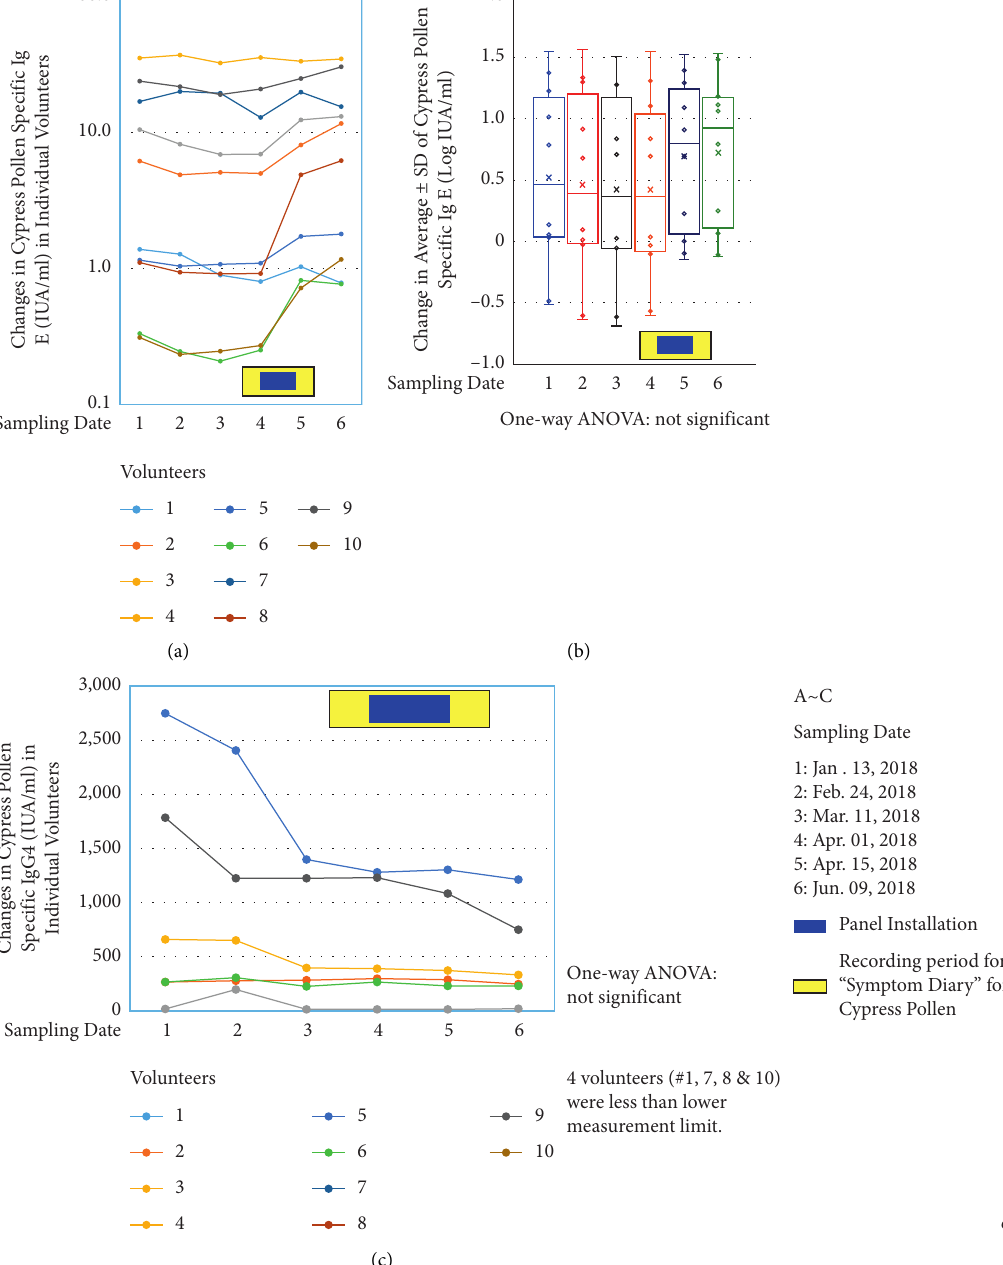
Figure 5: Changes in immunoglobulins. (a) Actual changes in cypress-specific IgE in 10 volunteers. The X -axis shows the six blood collection times described in Figure 2(b) and the lower right part of this figure. The Y -axis is represented logarithmically. As shown in the lower right part, the yellow box shows the period when the “Symptom Diary” was kept for cypress pollen allergy, while the blue box indicates the 2 weeks of exposure to CCSNOP. (b) The data in panel A are shown as box plots of cypress-specific IgE of 10 volunteers with average ± standard deviations. The Y -axis is shown as Log IgE IUA/ml. There were no significant differences identified among these data by one-way ANOVA analysis. The blue and yellow boxes are the same as in panel (a). Sampling dates # 1 to 6 are the same as in Figure 2(b) and are shown in the lower right part of this figure. (c) Changes in cypress-specific IgG4 (IUA/ML) in individual volunteers, except volunteers # 1, 7, 8, and 10 whose numbers are written in gray. These four volunteers showed less than the measurement lower limit (200 IUA/ml) for all six sampling times. There were no statistical differences between sampling times as determined by one-way ANOVA analysis. The blue and yellow boxes are the same as in panel (a). Sampling dates # 1 to 6 are the same as in Figure 2(b) and are shown in the lower right part of this